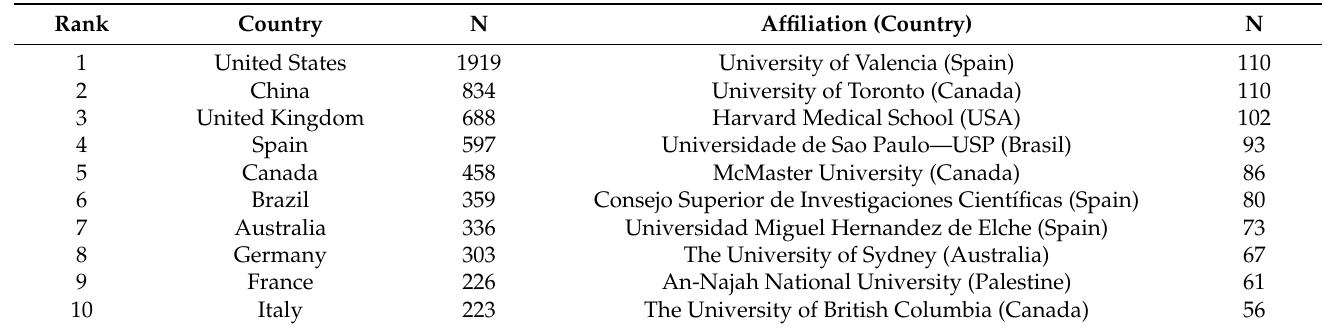
Table 11. Top 10 countries and affiliations publishing in Medicine category.